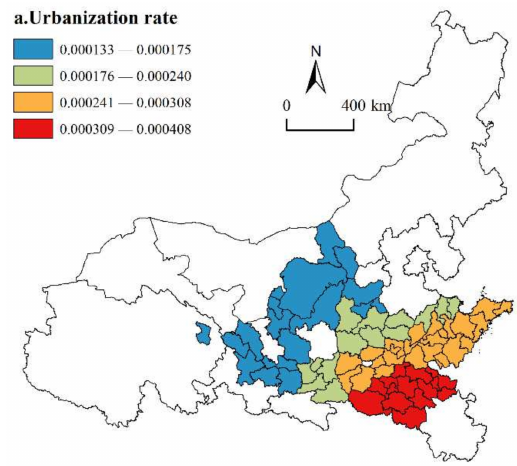
Figure 7. Spatial distribution of urbanization